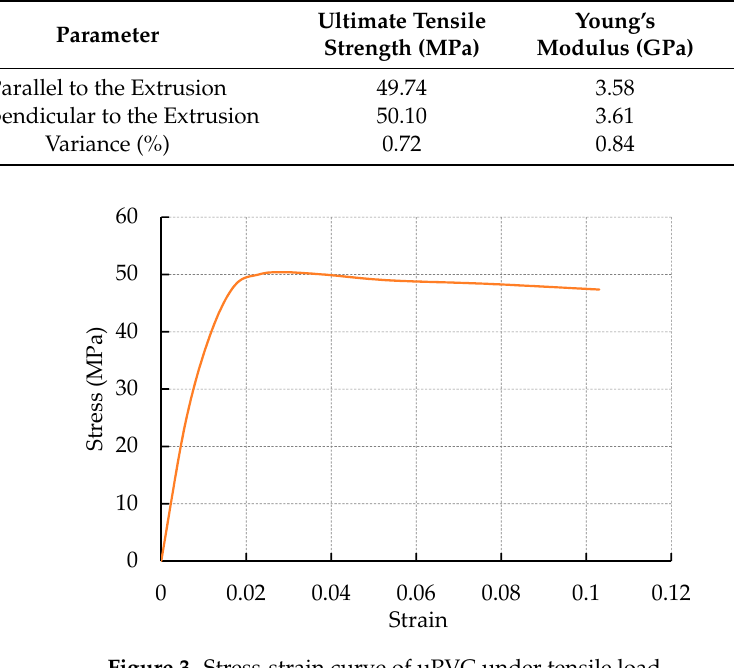
Figure 3. Stress-strain curve of uPVC under tensile load.